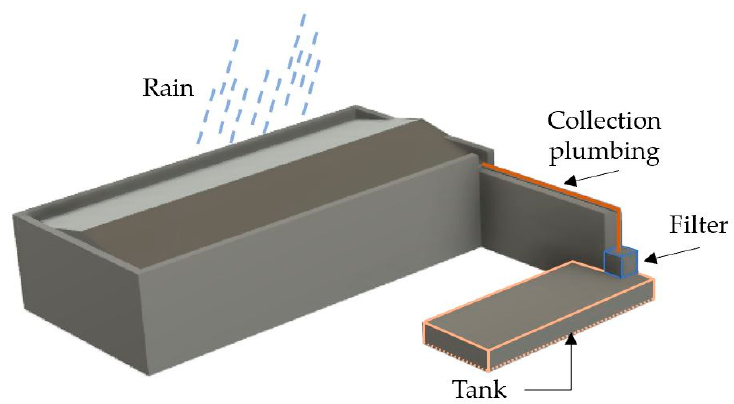
Figure 3. Schema domestic rainwater collection cistern, adapted from [1].